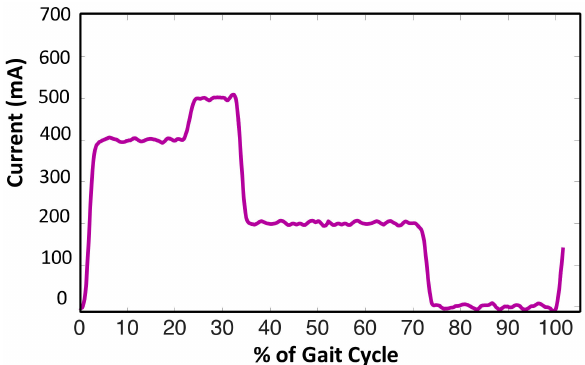
Figure 11. Actual current flowing in the MR damper during a typical gait